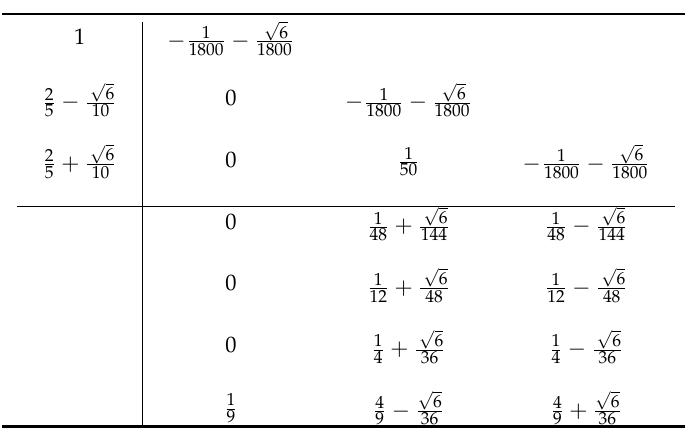
Table 2. The DIRKT5